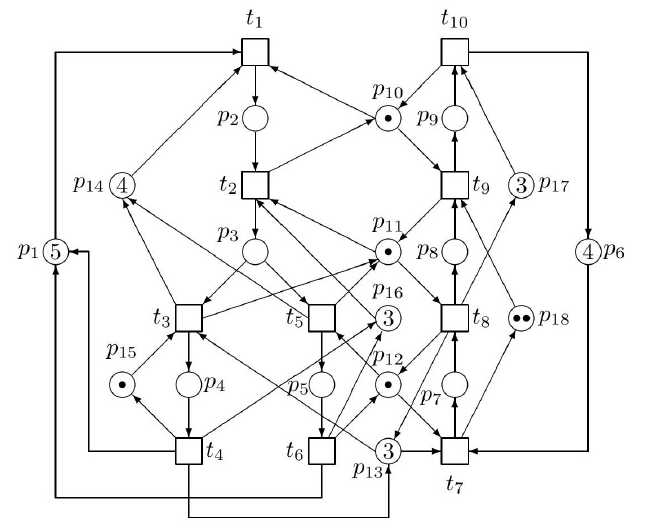
Figure 11. The PN